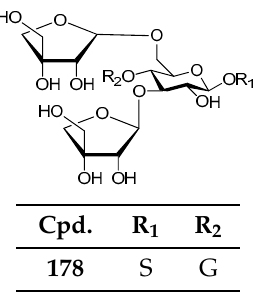
Cpd. Figure 22. Structures of compounds 176 – 177 . Figure 22. Structures of compounds 176 – 177 . Figure 22. Structures of compounds 176 – 177 . Figure 22. Structures of compounds 176 – 177 . Figure 22. Structures of compounds 176 – 177 .